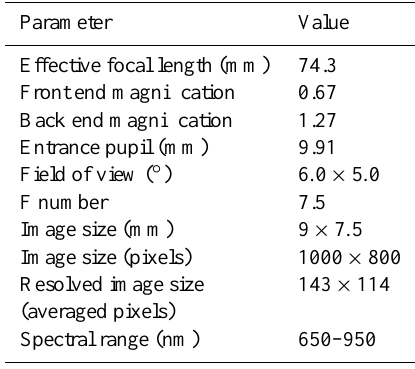
Table 1. ALI final system optical